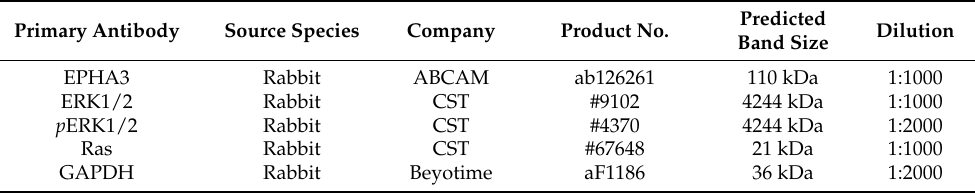
Table 3. Primary antibodies applied in this